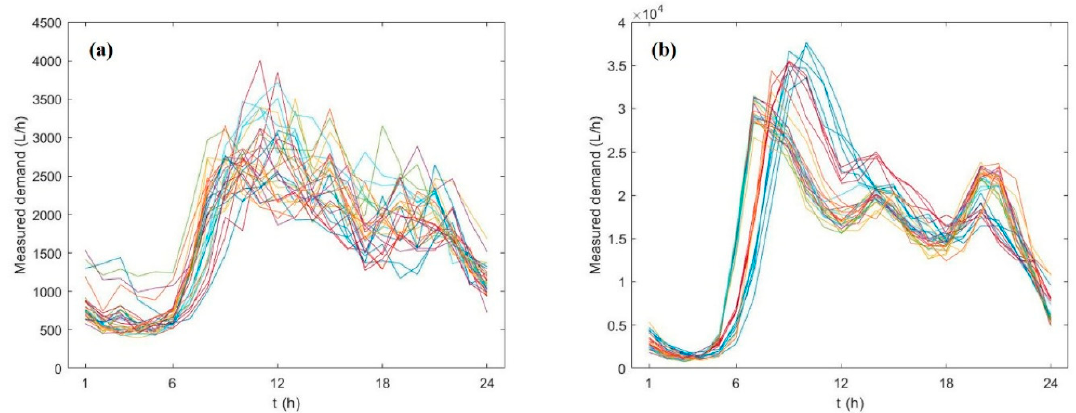
Figure 5. Patterns of aggregated measured hourly demand for 31 days for Case study 1 ( a ) and Case study 2 ( b ), respectively [16].